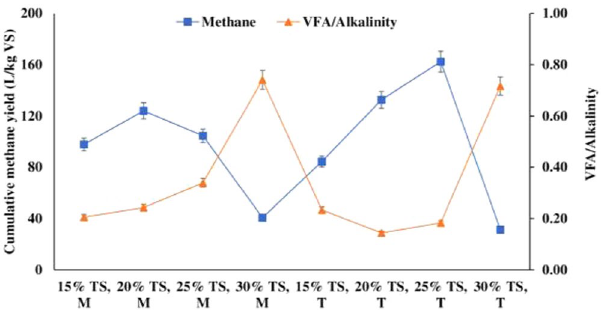
Figure 3. Spectrum of ( a ) Cumulative methane yield and ( b ) VFA/alkalinity ratio (P < 0.5)